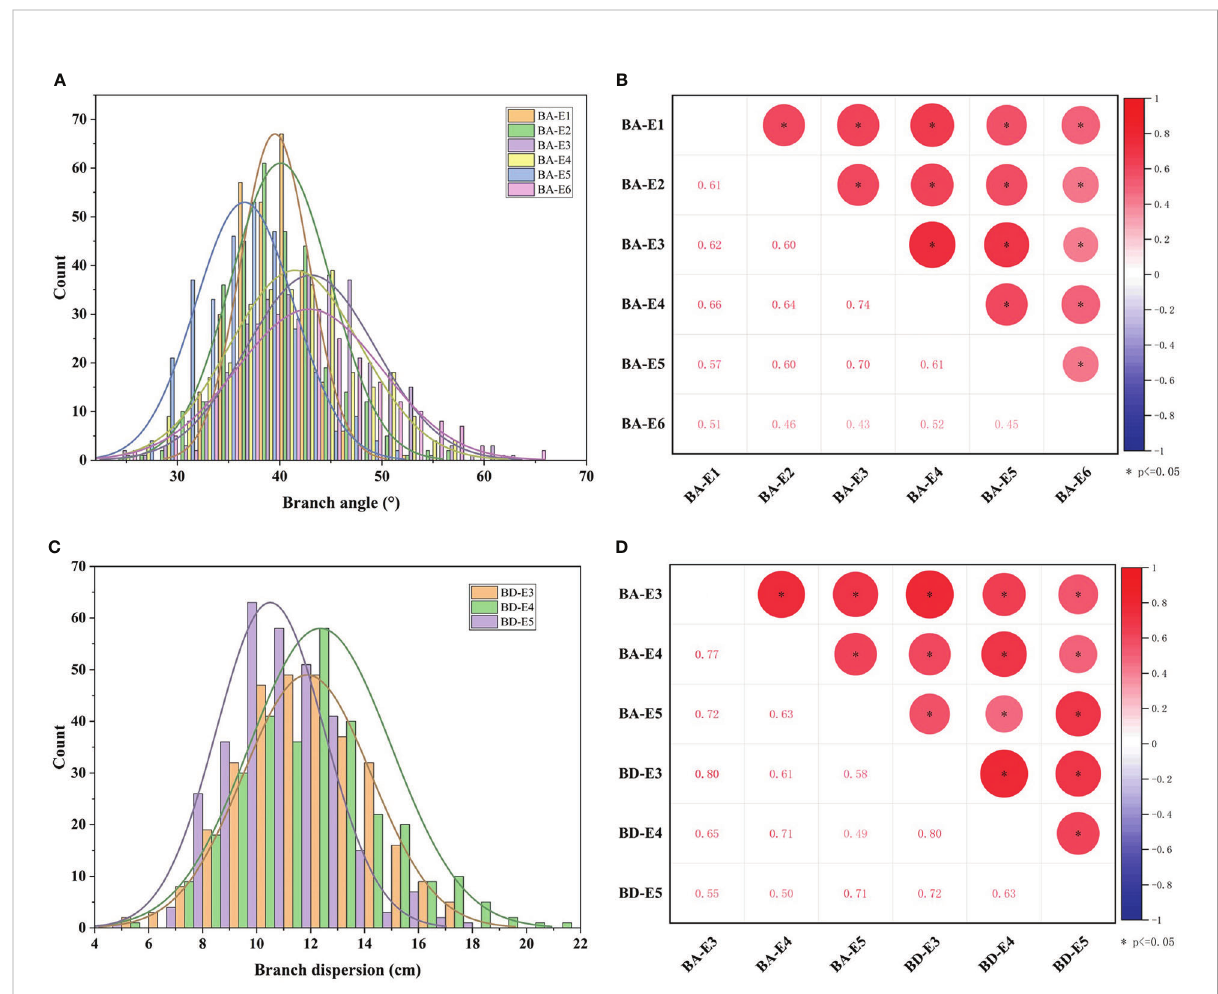
FIGURE 3 The phenotypic distribution and correlation of BA and BD across 327 accessions in environments. (A) The distribution of BA in six environments (BA-E1, BA-E2, BA-E3, BA-E4, BA-E5, and BA-E6). (B) The correlation analysis of BA between six environments. (C) The distribution of BD in three environments (BD-E3, BD-E4, and BD-E5). (D) The correlation analysis of BD and BA between E3, E4, and E5 environments. * represents the signi fi cance level of p ≤